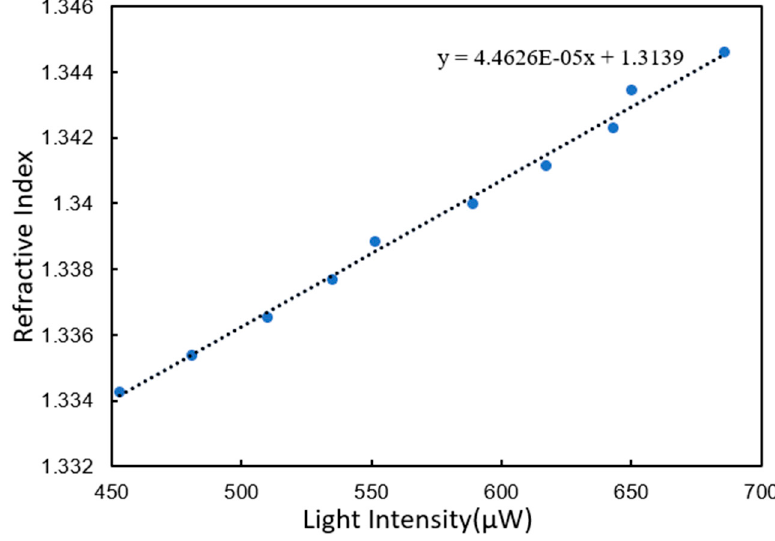
Figure 6. Linear regression curves of gold film chip modified with bovine serum albumin (BSA). The curve was linearly fitted with linear correlation coefficient 0.994. The slope of the fitting curve was 4.4626 × 10 − 5 . Similarly, the noise was calculated using 500 measurements of deionized water. The variance of the 500 points was 1.4382 × 10 − 2 . Similarly, the refractive index resolution was calculated to be 1.9254 × 10 − 6 RIU.